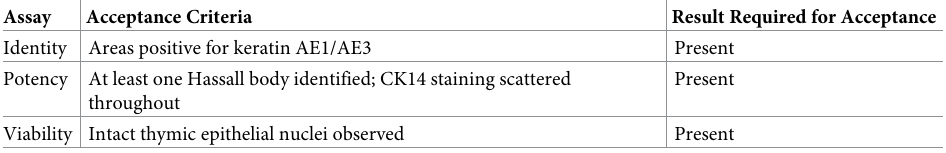
Table 2. Diagnostic criteria for thymus that has been cultured for one or more days � .